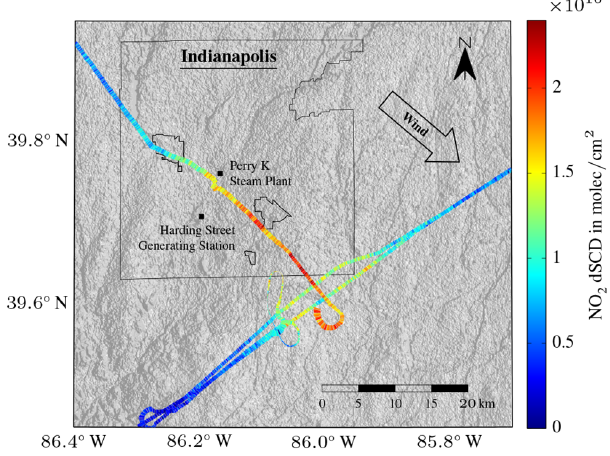
Figure 20. Detail of the flight on 24 October 2011 showing mea- sured NO 2 column densities plotted into a relief map of the area around Indianapolis (Indiana, USA). The displayed data was taken between 17:07 and 18:31UTC with a binning of 1 × 128. Clearly visible is the NO 2 plume originating from Indianapolis with its coal-burning power plants blowing downwind. For a bet- ter overview only data for flight altitudes below 1000m are plotted